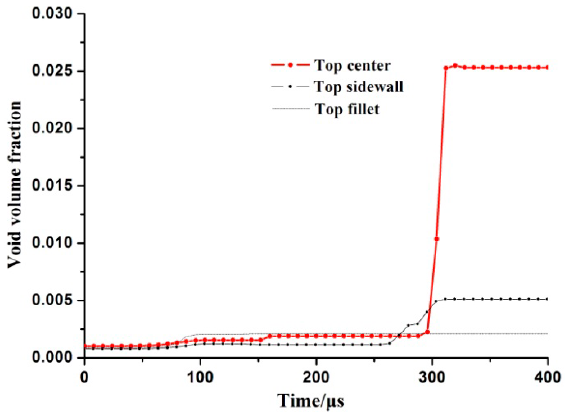
Figure 21. Void evolution in different positions.